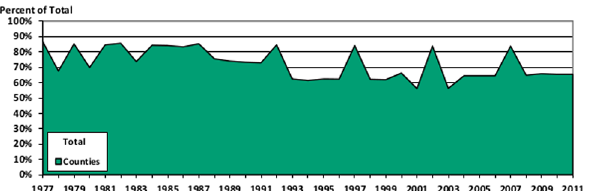
Fig 6. Population Coverage for Sampled County Governments. This figure graphs the population covered by the counties in the database, and compares it to the population indicated at the state level for every year of the data.